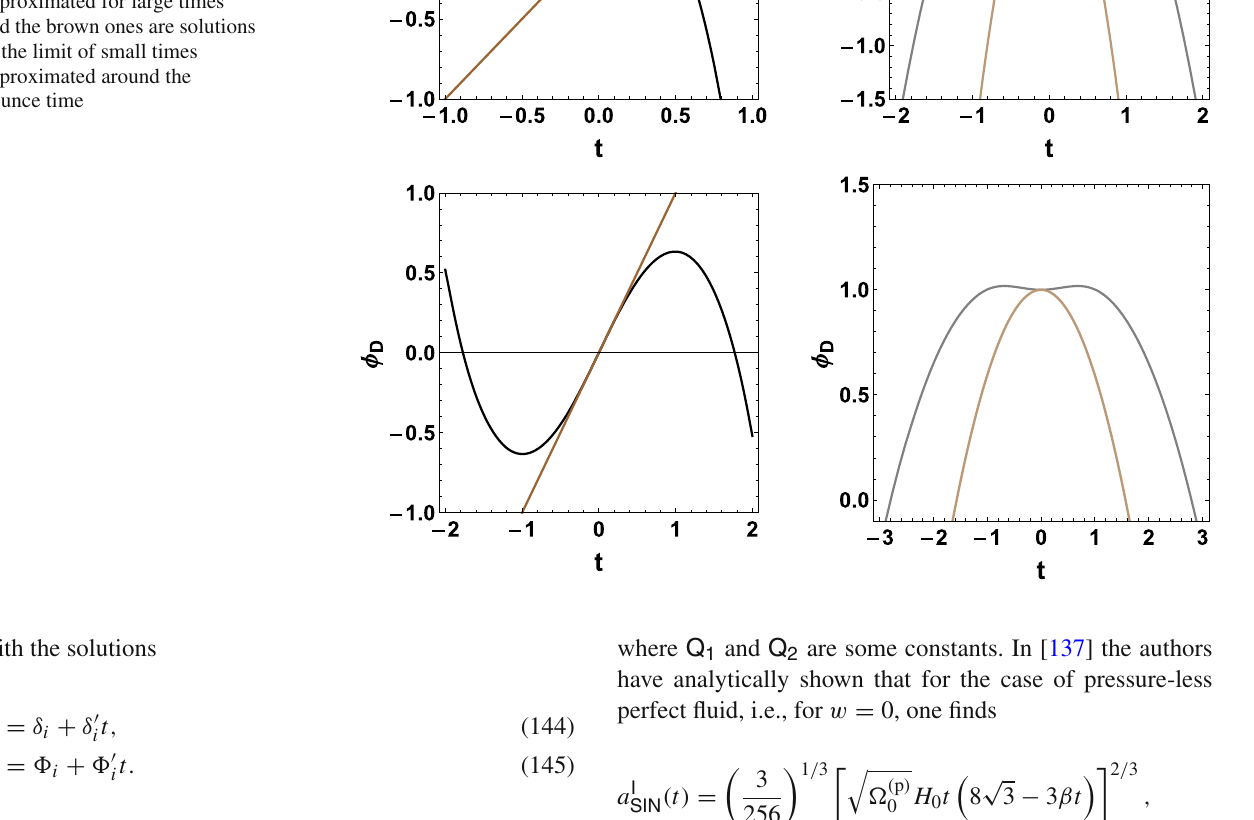
Fig. 11 The evolution of δ and (cid:23) for model D . The Left panels are plotted for initial values δ( 0 ) = 0 ,δ (cid:8) ( 0 ) = 1 ,(cid:22)( 0 ) = 0 and (cid:22) (cid:8) ( 0 ) = 0. The right panels are drawn for δ( 0 ) = 1 , δ (cid:8) ( 0 ) = 0 ,(cid:22)( 0 ) = 1 and (cid:22) (cid:8) ( 0 ) = 0. The black curves are the solutions of equations approximated for large times and the brown ones are solutions in the limit of small times approximated around the bounce